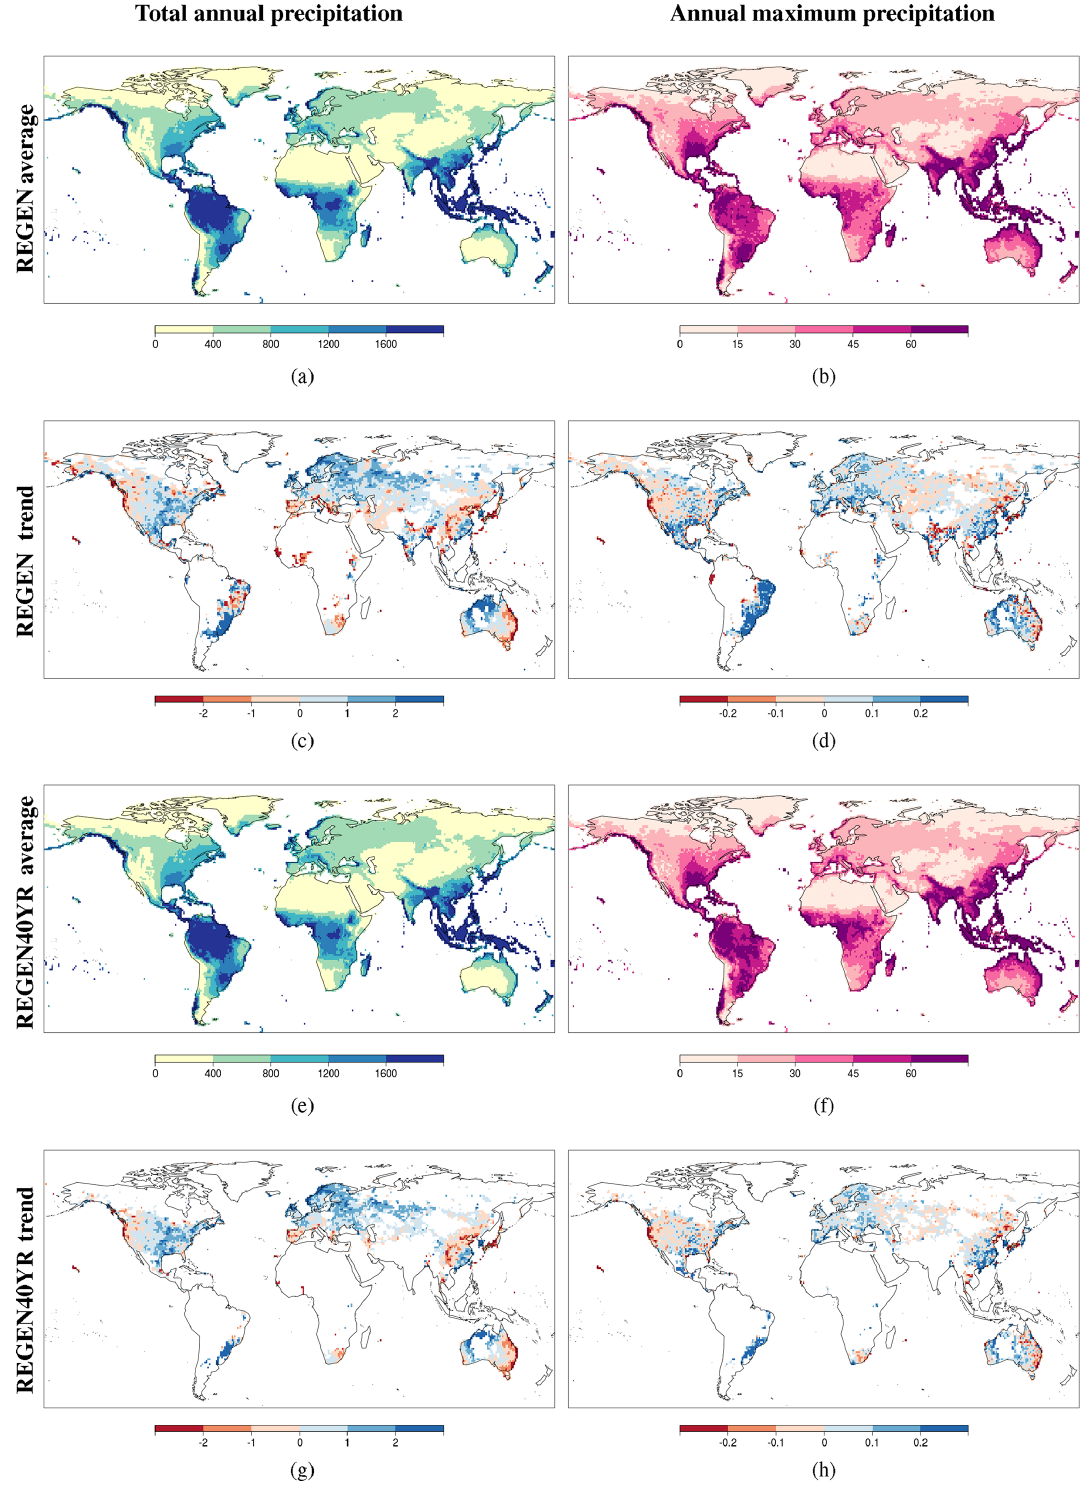
Figure 13. Total annual precipitation (a, e) , maximum annual precipitation (b, f) and respective trends (PRCPtot; c and g and RX1DAY; d and h ) averaged over 1950 to 2016 based on REGEN data (a–d) and REGEN40YR data that only interpolates stations with at least 40 complete years of data (e–h)